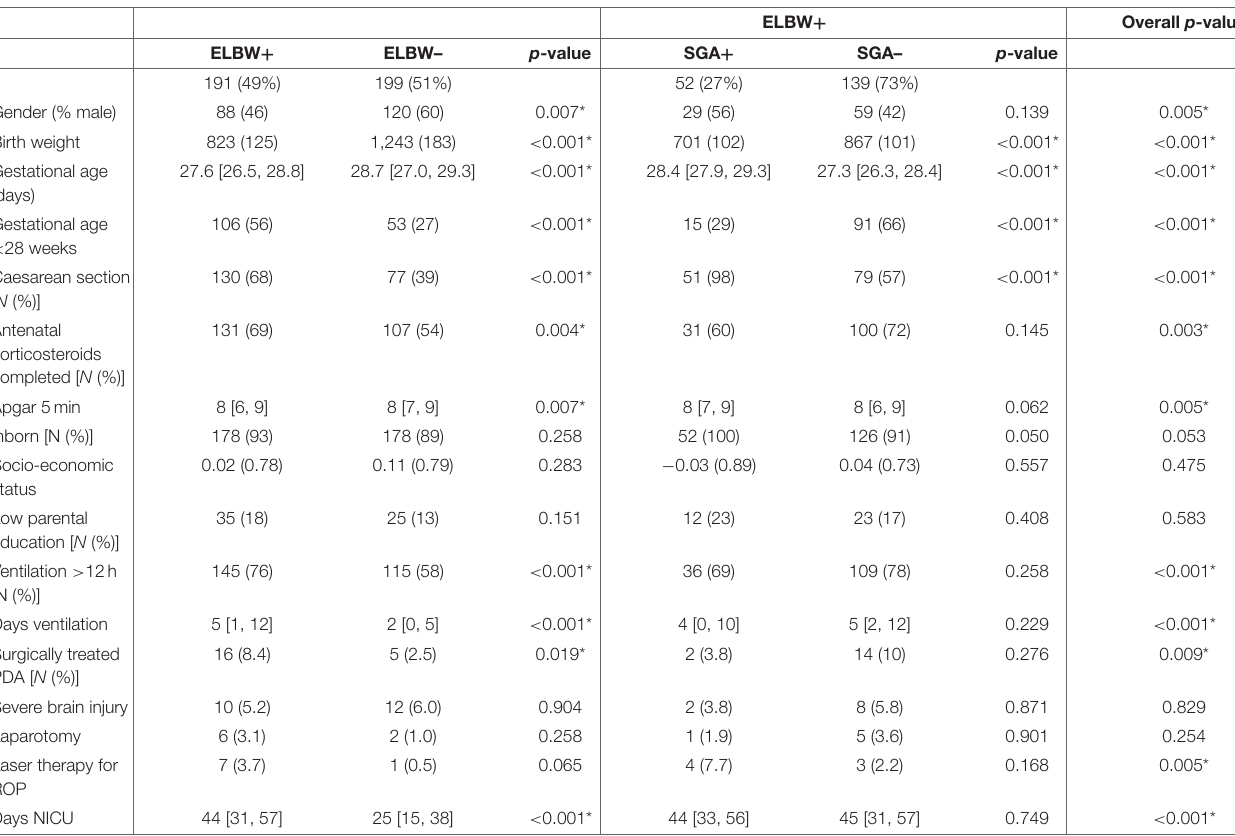
TABLE 1 | Baseline